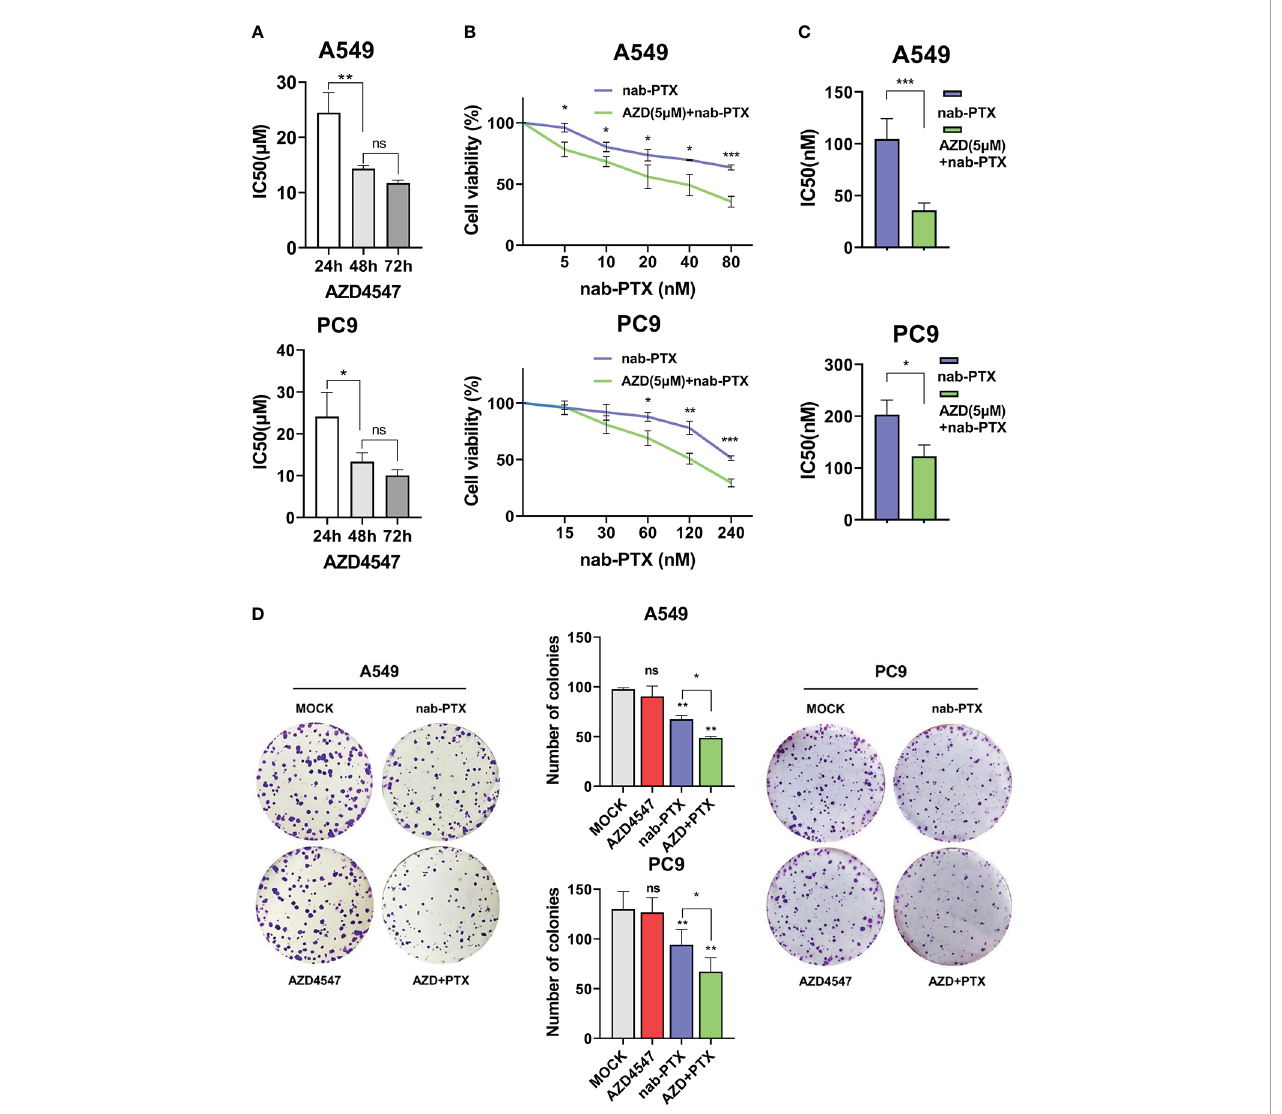
FIGURE 1 AZD4547 combined with nab-PTX signi fi cantly inhibited cell proliferation in vitro . (A) IC50 of AZD4547 in A549 and PC9 cells at different time points. (B, C) Cells cotreated with 5 m M AZD4547 and varying concentrations of nab-PTX showed larger reductions in proliferation than cells treated with nab- PTX alone. (D) Colony formation assay. Cells cotreated with AZD4547 (5 m M) and nab-PTX (A549 cells 20 nM, PC9 cells 60 nM) exhibited signi fi cantly less colony formation than cells treated with nab-PTX alone. No signi fi cant change was observed in cells treated with AZD4547 alone. ns: no signi fi cance, *: p< 0.05, **: p< 0.01, ***: p<